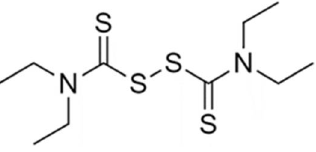
Figure 1. Chemical structure of disulfiram (DS).